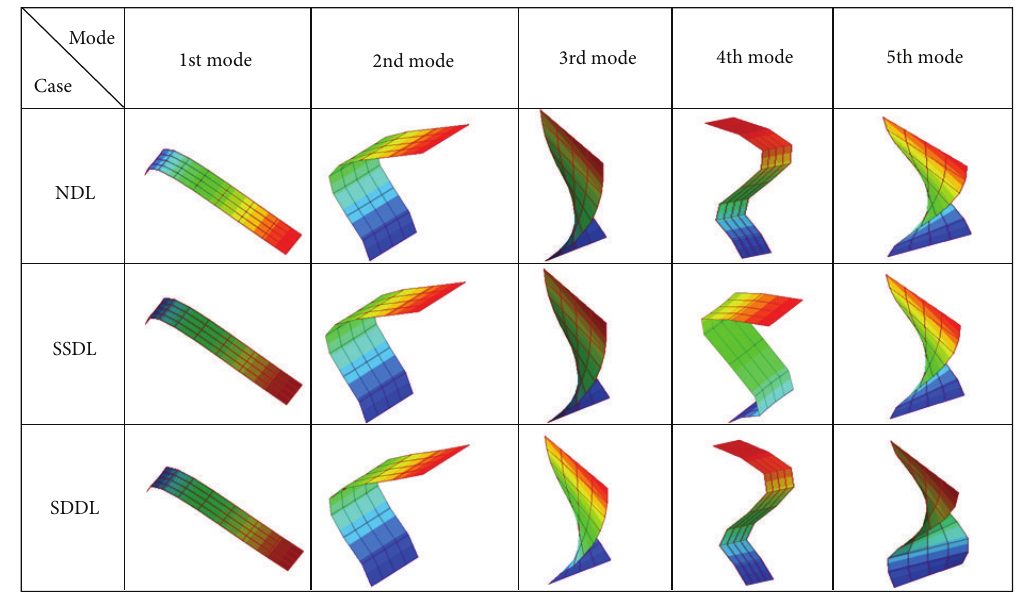
Figure 14: Mode shapes in case of NDL, SSDL, and